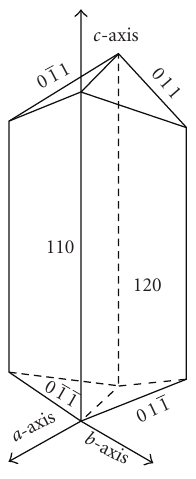
Figure 11: Morphology of L-threonine single crystal.